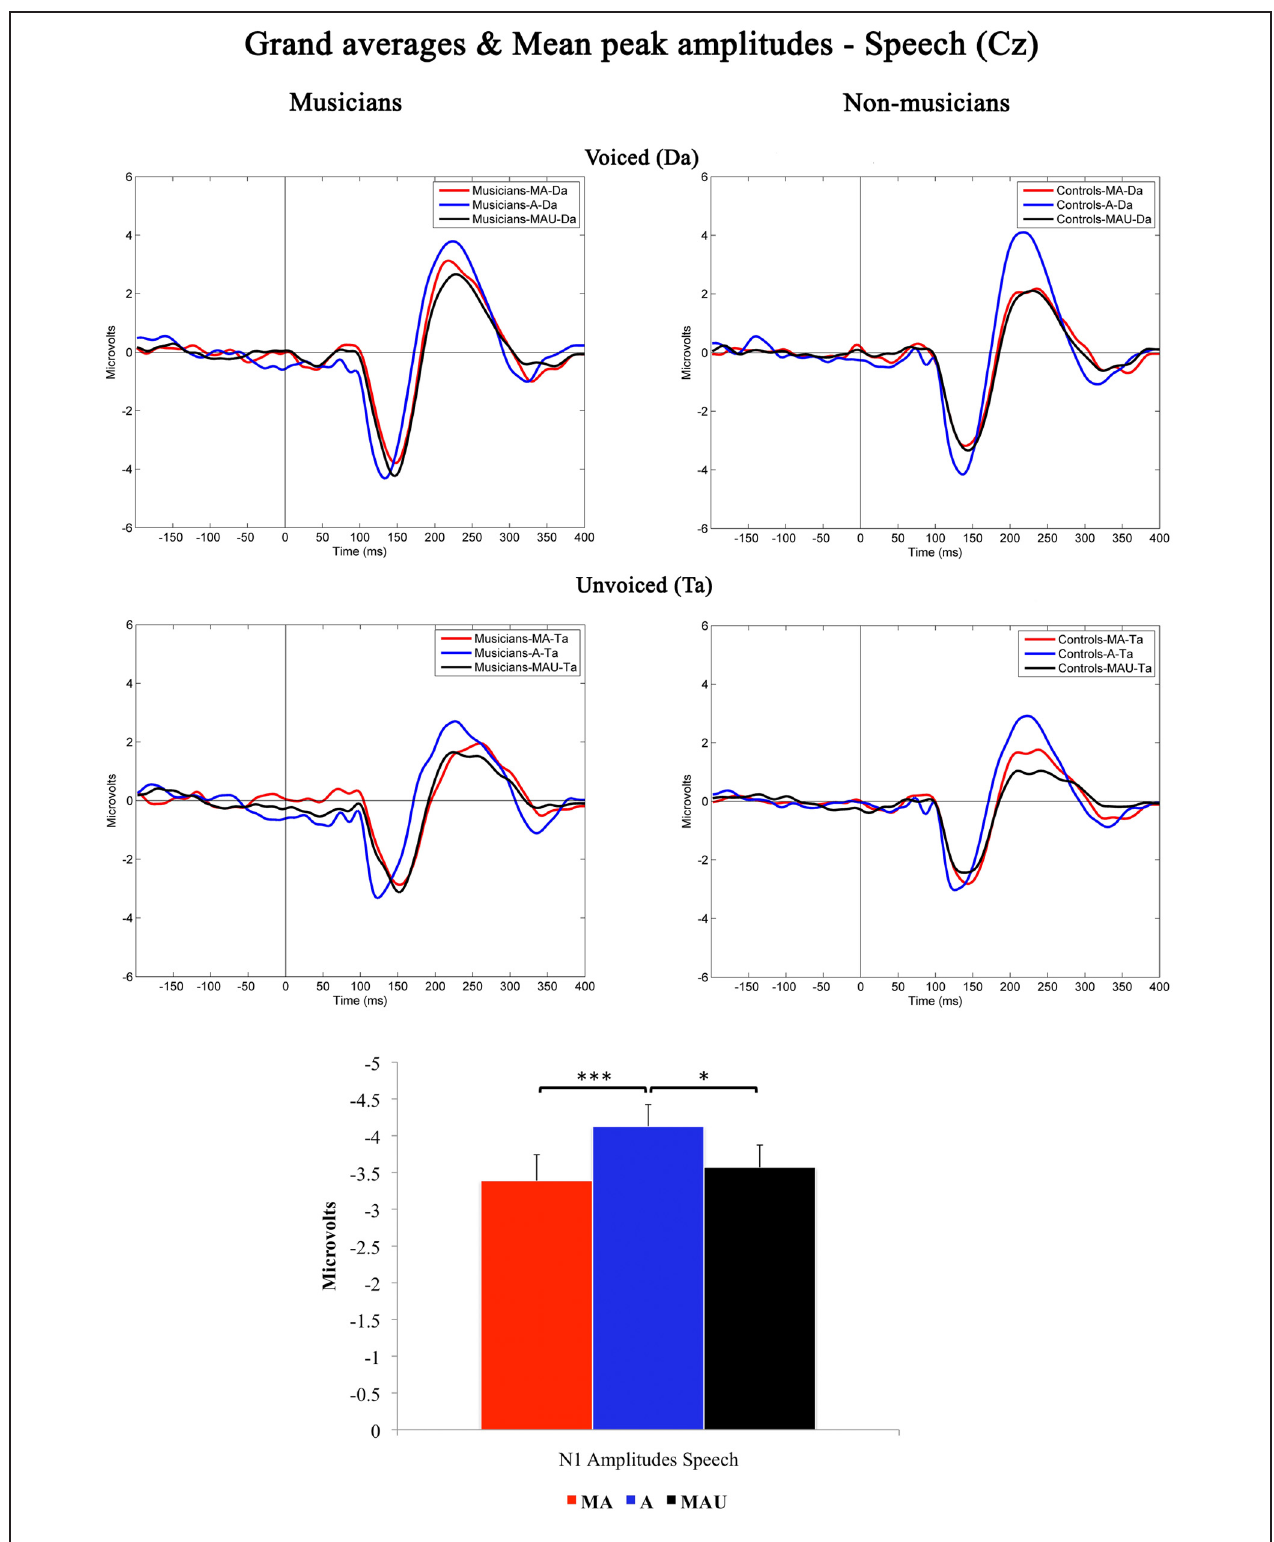
FIGURE 1 | Grand-averaged waveforms and corresponding mean N1 peak amplitudes evoked by voiced (top) and unvoiced (bottom) CV-syllables recorded at Cz for musicians (left) and non-musicians (right). MA, Motor-Auditory task; A, Auditory-Only task; MAU, Motor-Auditory